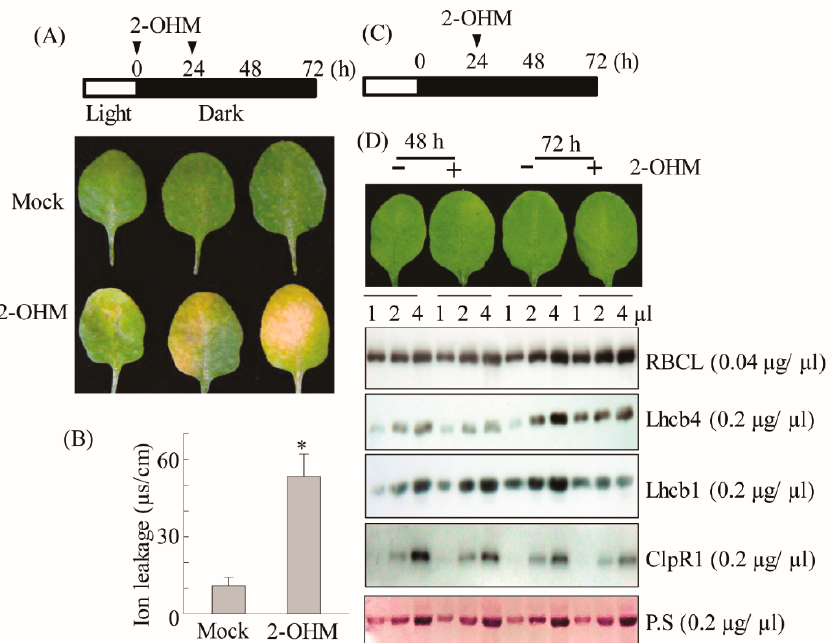
Figure 7. ( A ) Schematic diagram of 2-OHM treatment for senescence induction and the resulting phenotypes. ( B ) Ion leakage measurement. ( C ) Schematic diagram of 2-OHM treatment for physio- logical tests. ( D ) Western blot analysis using anti-RBCL, -Lhcb4, -Lhcb1, and -ClpR1 antibodies